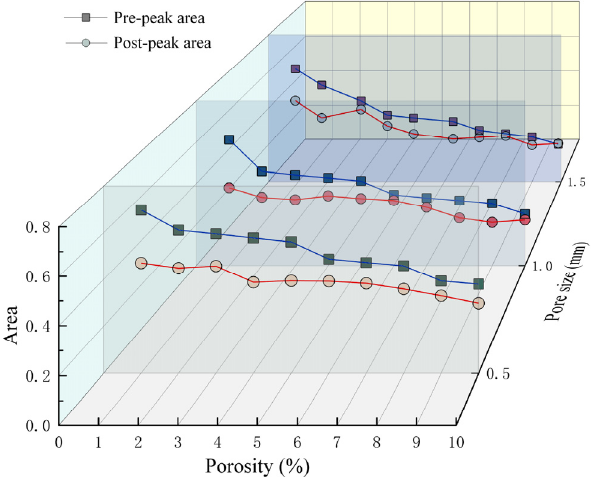
Figure 11. Pre-peak and post-peak area statistics.